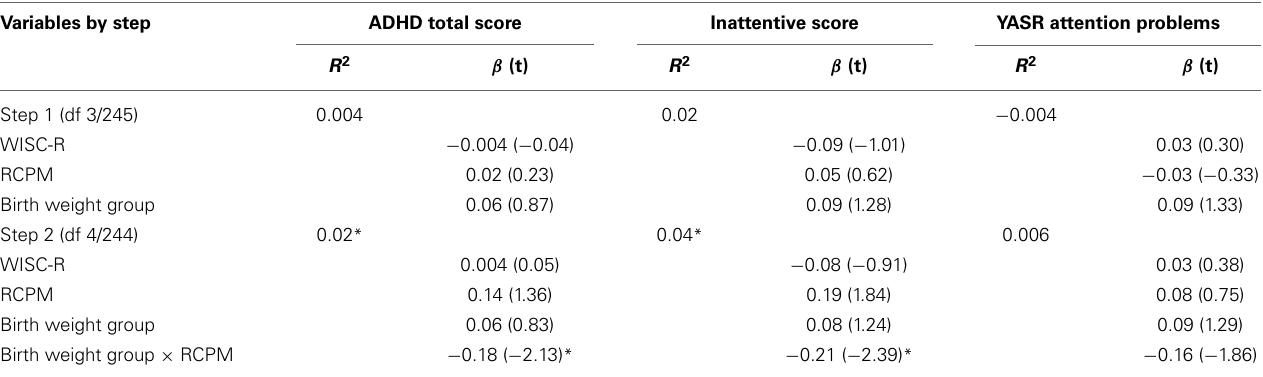
Table 2 | Hierarchical multiple regression analysis predicting ADHD symptoms. Variables by